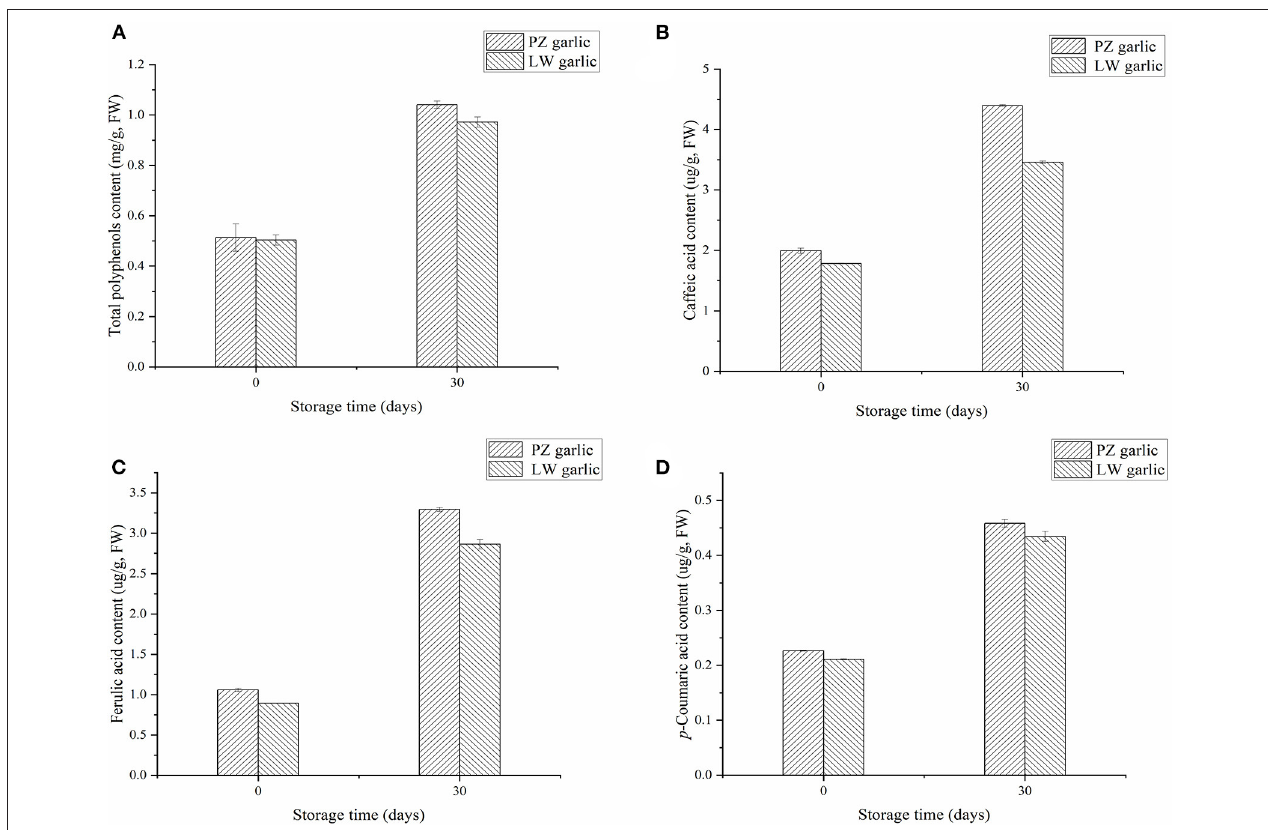
FIGURE 6 | Relative contents of different compounds involved in phenylpropane pathway. (A) Total polyphenols content. (B) Caffeic acid content. (C) Ferulic acid content. (D) p -coumaric acid content.